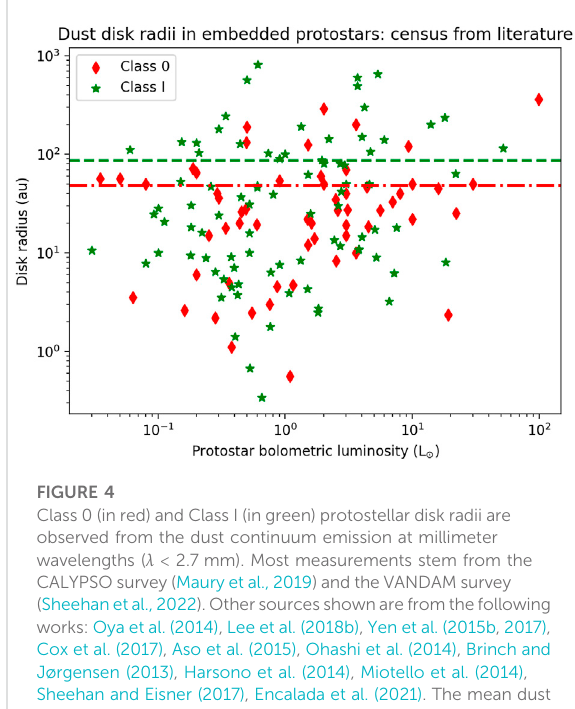
FIGURE 4 Class 0 (in red) and Class I (in green) protostellar disk radii are observed from the dust continuum emission at millimeter wavelengths ( λ < 2.7 mm). Most measurements stem from the CALYPSO survey (Maury et al., 2019) and the VANDAM survey (Sheehanetal.,2022).Othersourcesshownarefromthefollowing works: Oya et al. (2014), Lee et al. (2018b), Yen et al. (2015b, 2017), Cox et al. (2017), Aso et al. (2015), Ohashi et al. (2014), Brinch and Jørgensen (2013), Harsono et al. (2014), Miotello et al. (2014), Sheehan and Eisner (2017), Encalada et al. (2021). The mean dust disk radii for each Class are indicated as horizontal lines (48 au for Class 0 and 86 au for Class